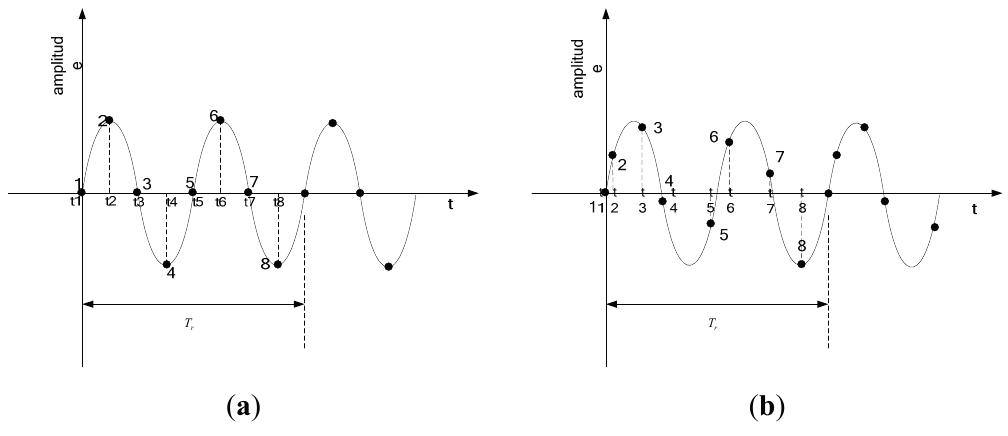
Figure 2. ( a ) The uniform sampling; ( b ) The non-uniform